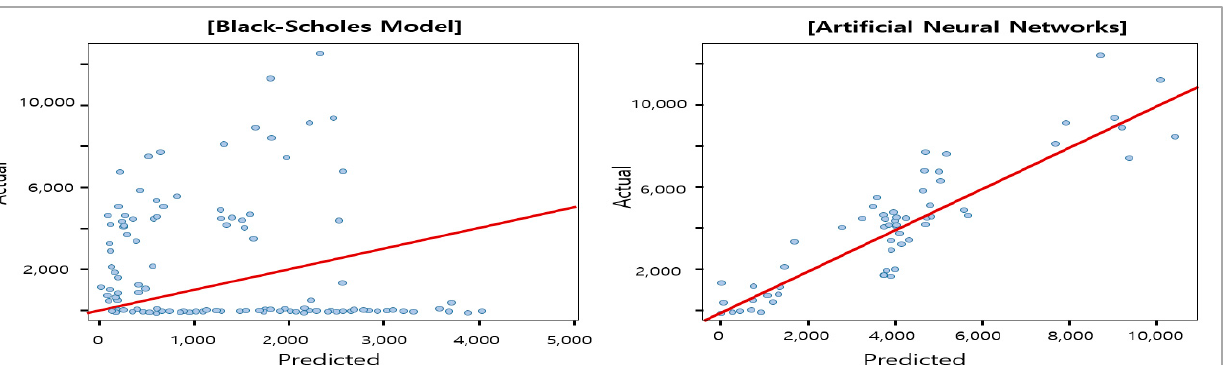
10 of 14 Figure 7. Selection of optimal parameters of random forest.